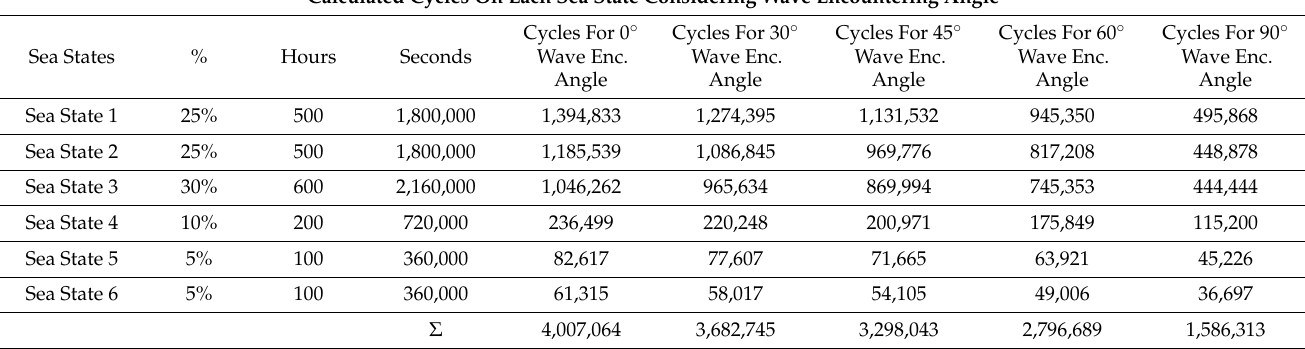
Table 5. Encounter cycle vs. sea state